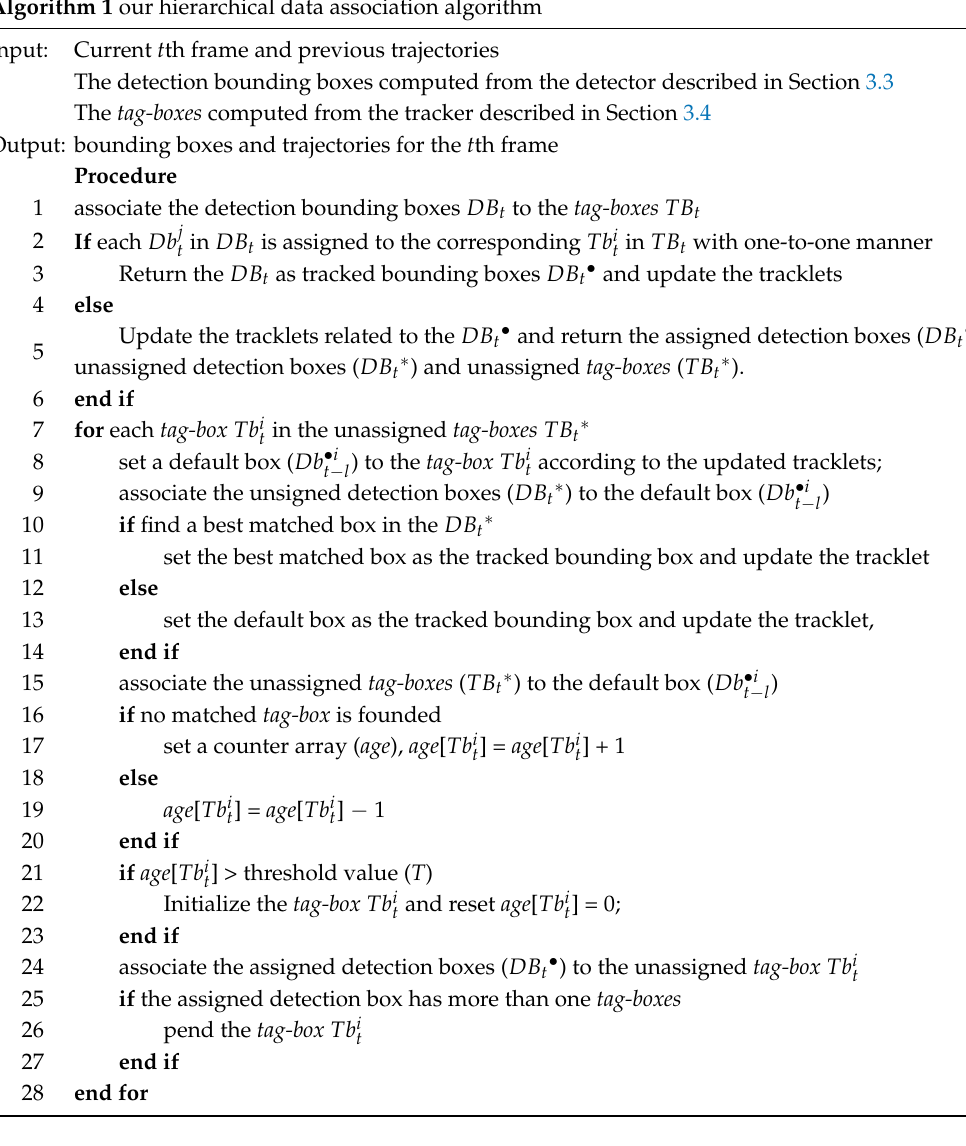
Algorithm 1 our hierarchical data association